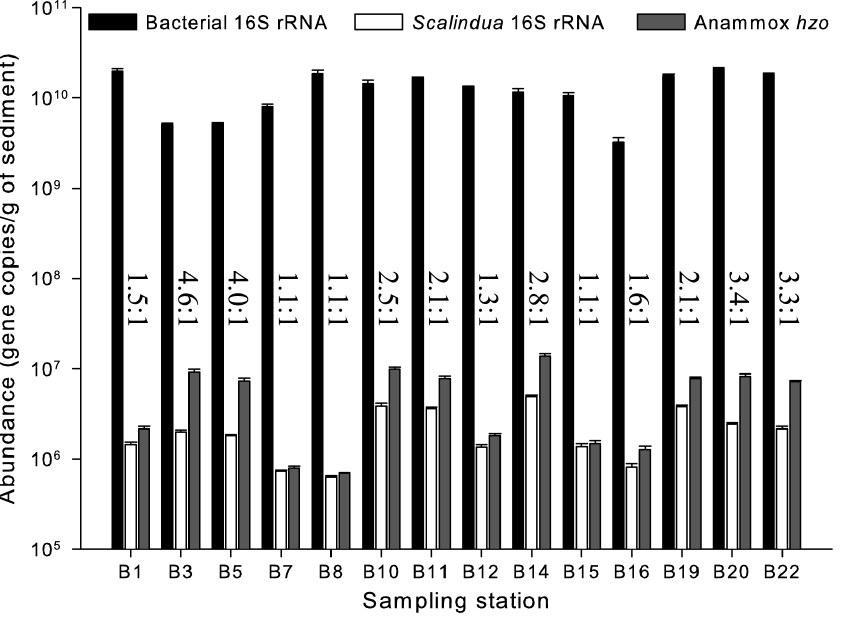
Figure 7. Abundances of the Bohai Sea sediment total bacteria, Ca . Scalindua bacteria and total anammox bacteria. These data were determined via qPCR specific to the respective target genes. The means and standard errors were calculated with three replicate qPCR measurements. The numerical values in the graph show the ratios of the total anammox bacterial hzo gene abundance to the Ca . Scalindua bacterial 16S rRNA gene abundance at each specific sampling station.